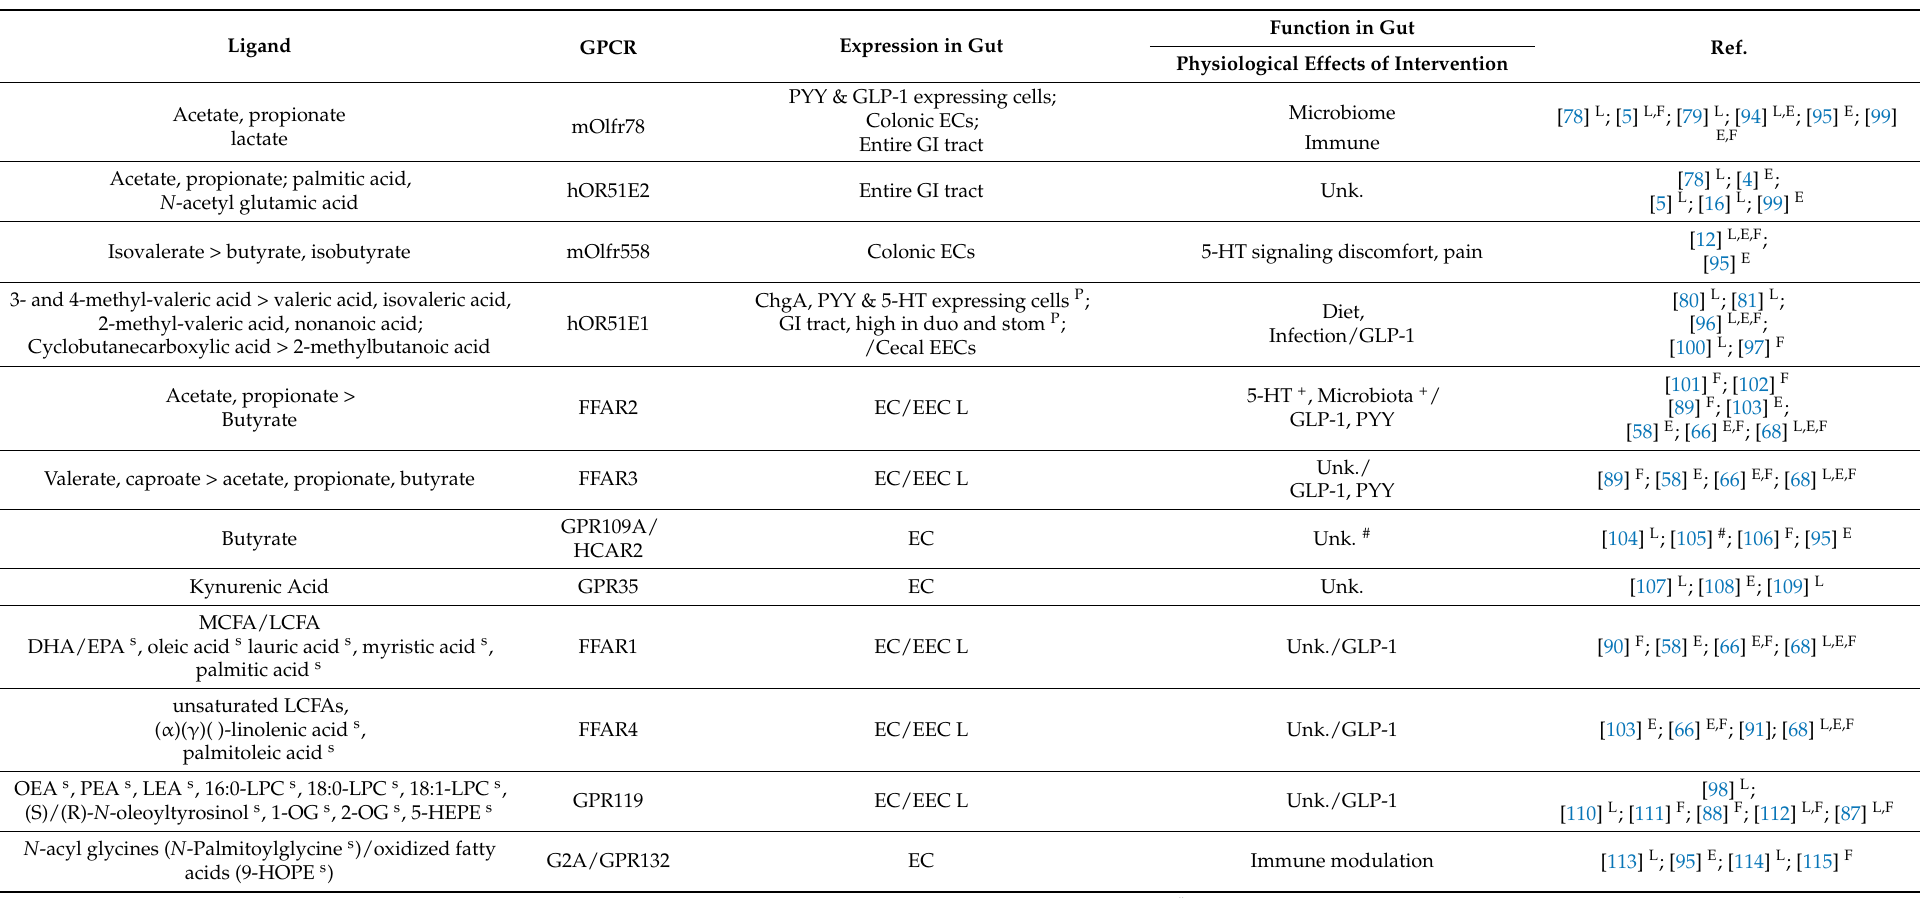
Table 1. Fatty acid ligands with their GPCR receptors, tissue and cell (EC and/or L cell) expression, and potential function in 5-HT and GLP-1/PYY signaling in gut. Ligand GPCR Expression in Gut